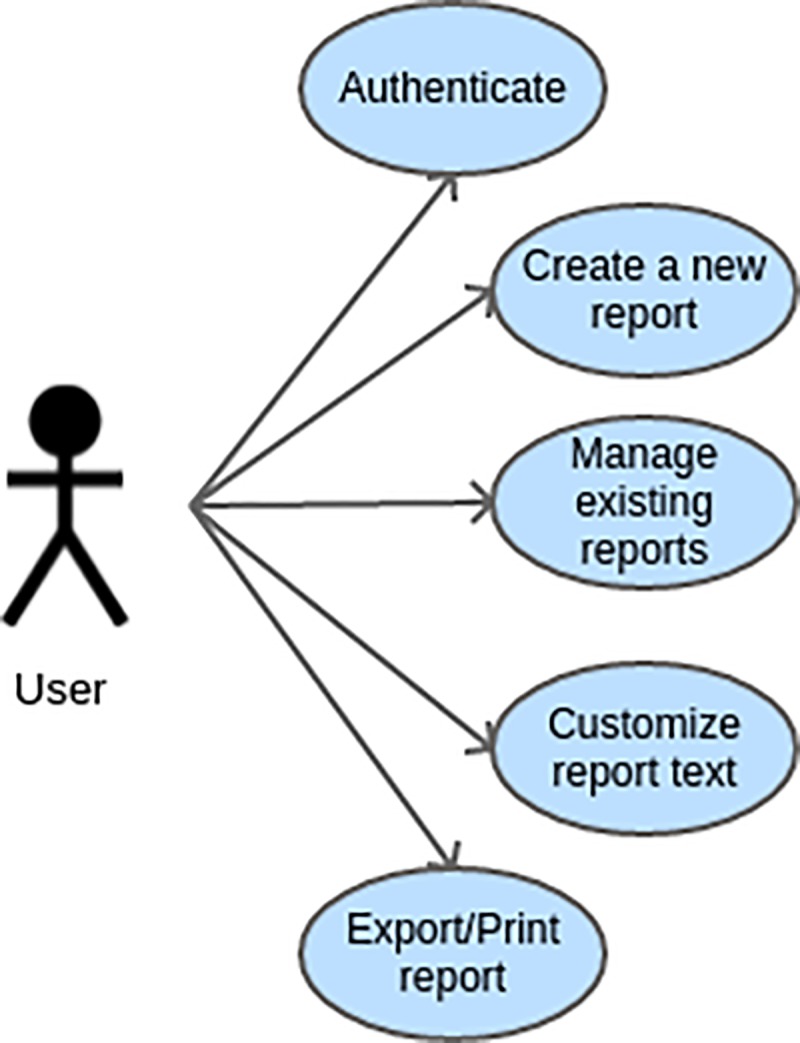
Use case diagram.